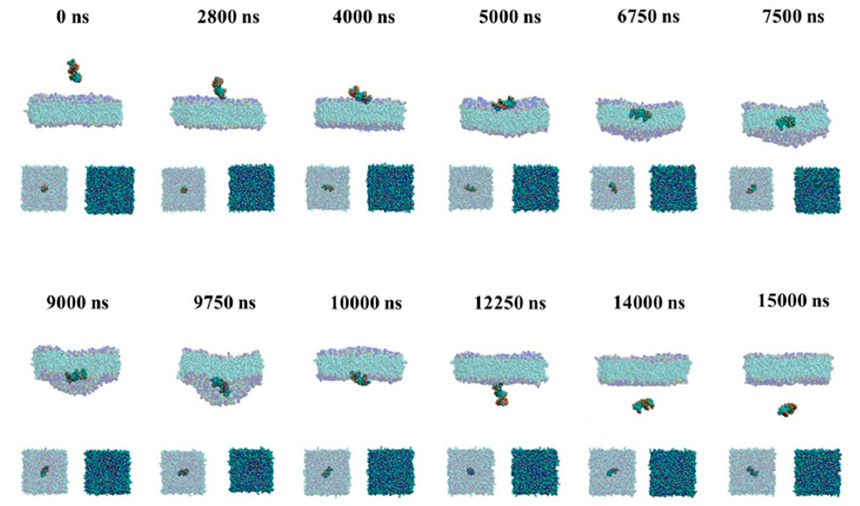
Figure 3. Snapshots of passive transmembrane process of the naked siRNA. The major graphs are front view of process and the small graphs are upper view.